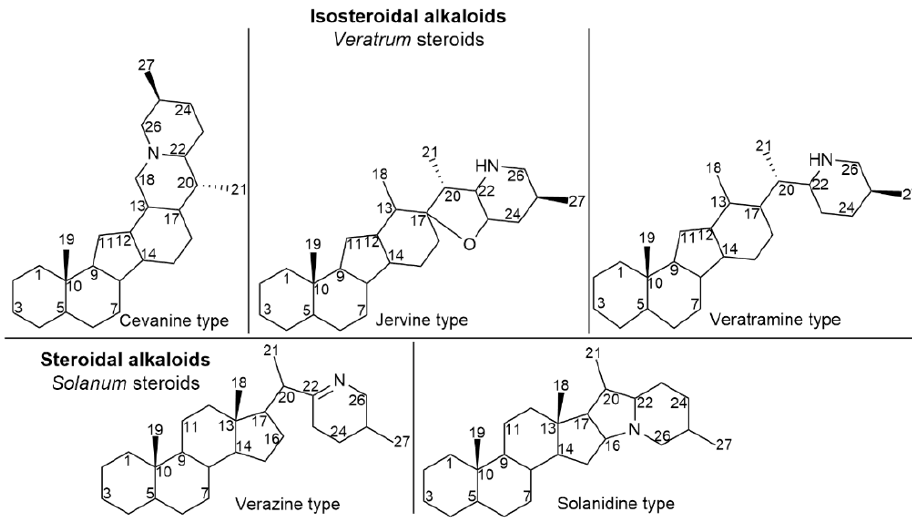
Figure 1. The types of steroidal alkaloids in Fritillaria species.